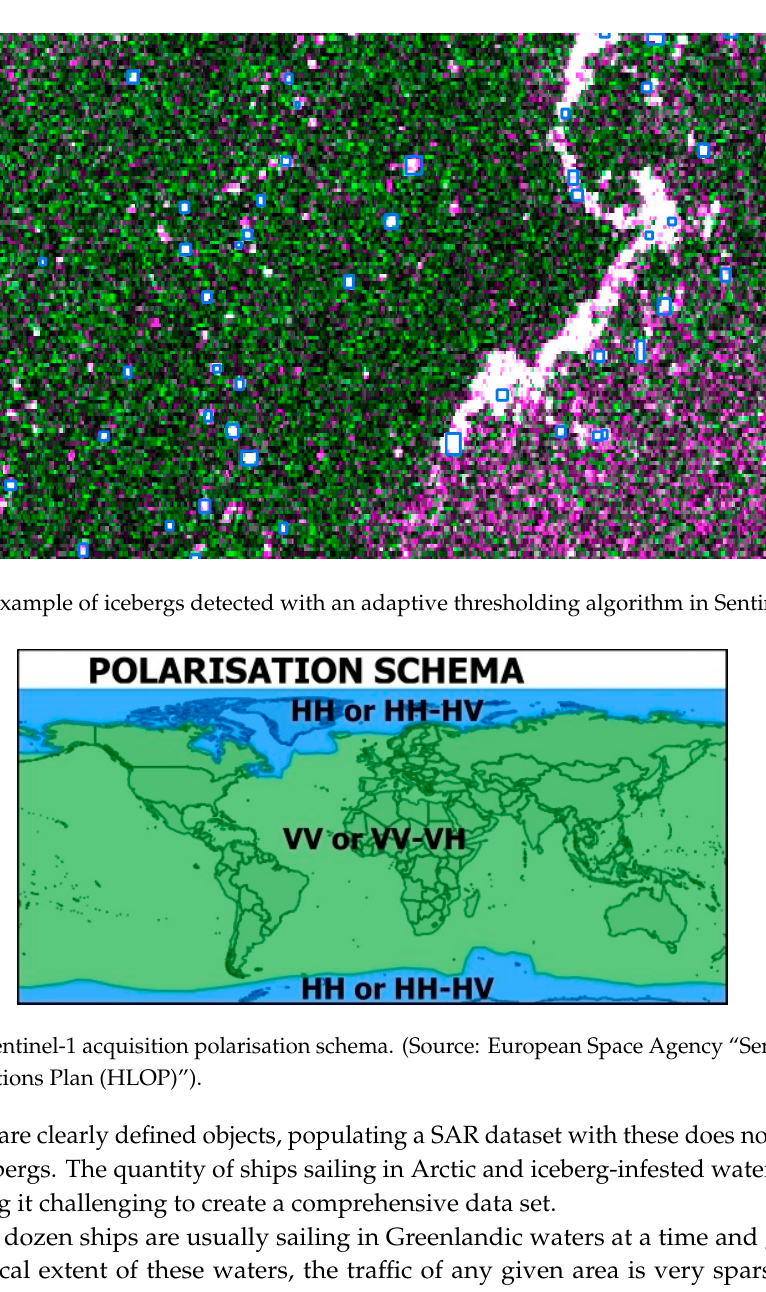
Figure 11. Sentinel-1 acquisition polarisation schema. (Source: European Space Agency “Sentinel High Level Operations Plan (HLOP)”).